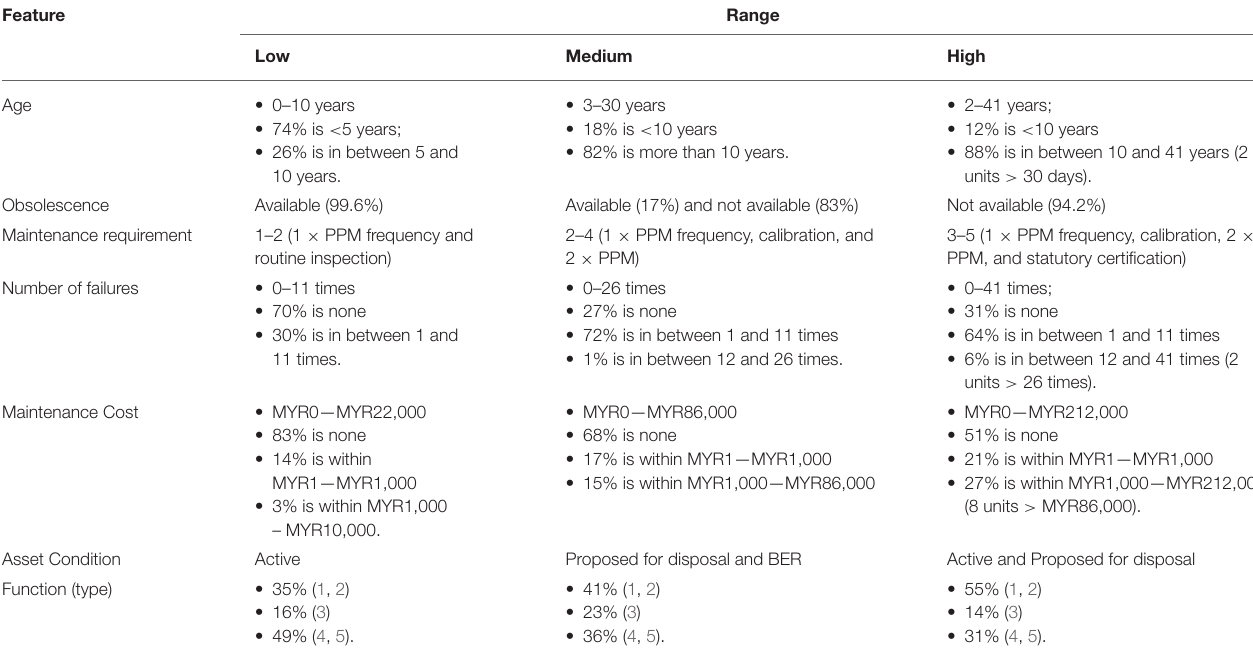
TABLE 9 | Findings of replacement programme prioritisation